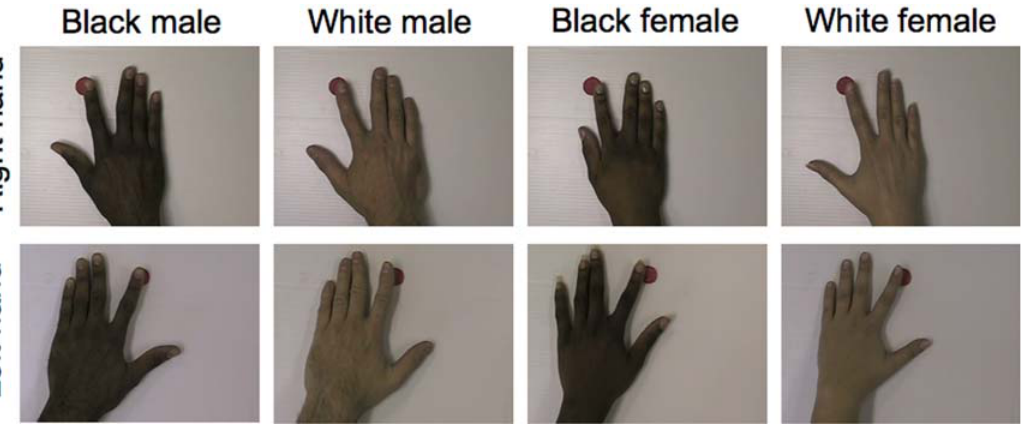
Figure 1. Participants observed index finger movements performed by a hand varying on color (black, white) and gender (male, female). The index finger moved toward the red dot at a pace of 1